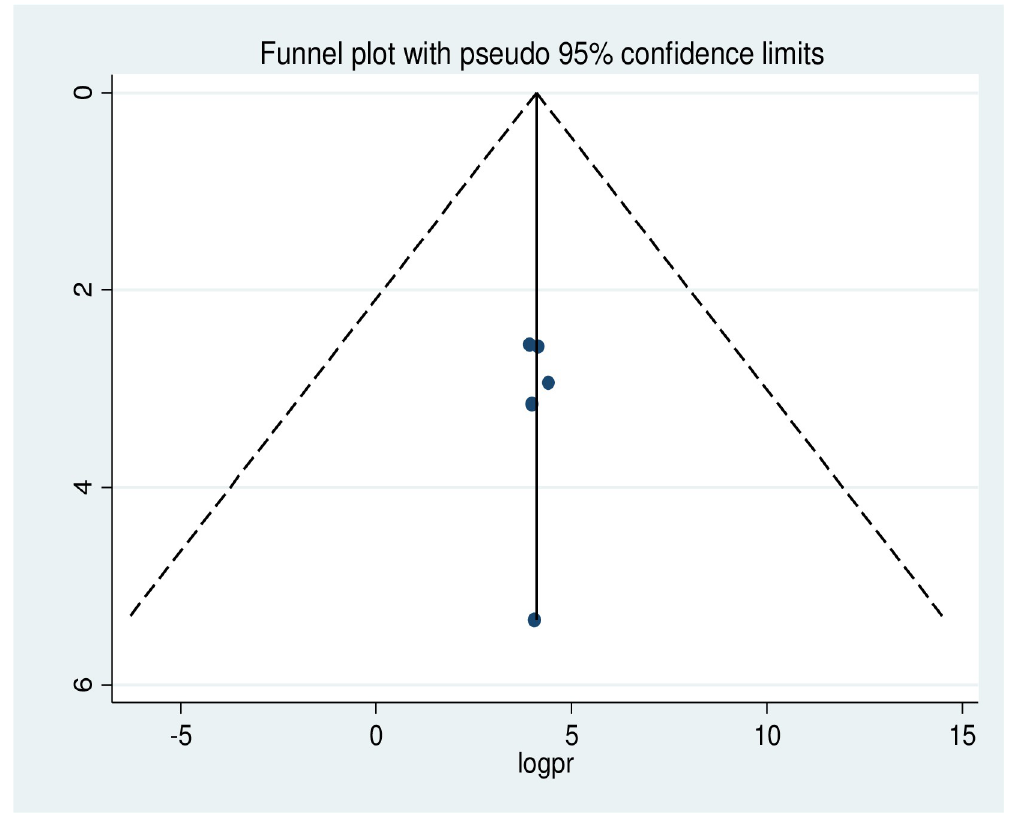
Fig 5. Funnel plot showing symmetrical distribution of studies indicating absence of publication bias. The Y-axis is the standard error and the X-axis is the study result or effect size. The dotted diagonal lie of the funnel is the 95% confidence interval and the vertical. The vertical line is the line of no-effect and dots are included studies reporting knowledge of kangaroo mother care.